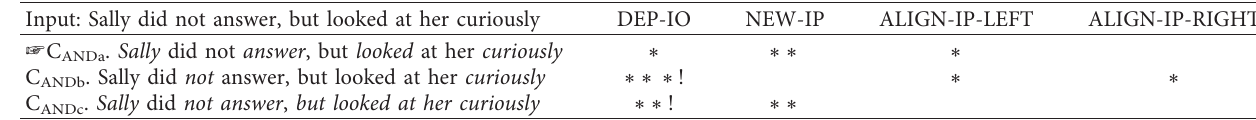
Figure 4: The histogram graph of violation rate of four constraints of native subjects. Table 4: An optimality-theoretic analysis of nonnative speakers.